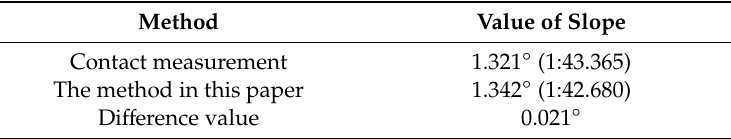
Table 6. Comparison of the two